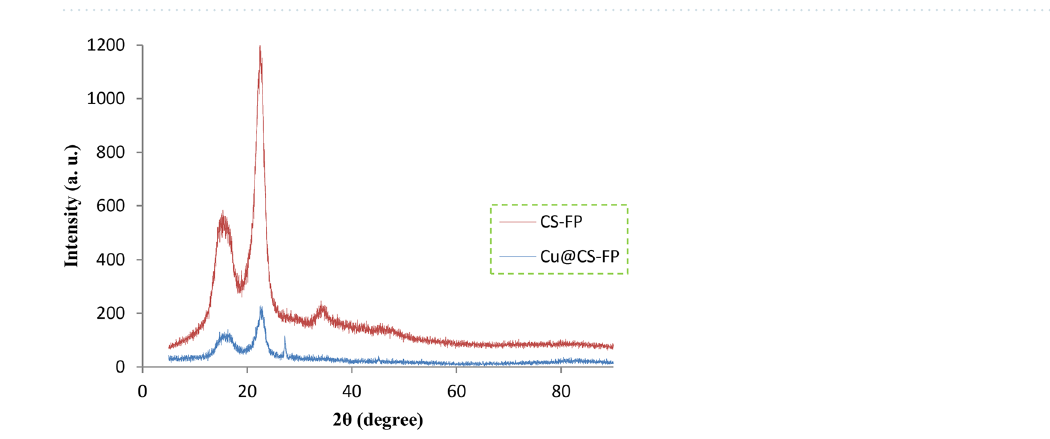
Figure 6. TGA and DTGA curves of the CS-FP, and Cu@CS-FP.